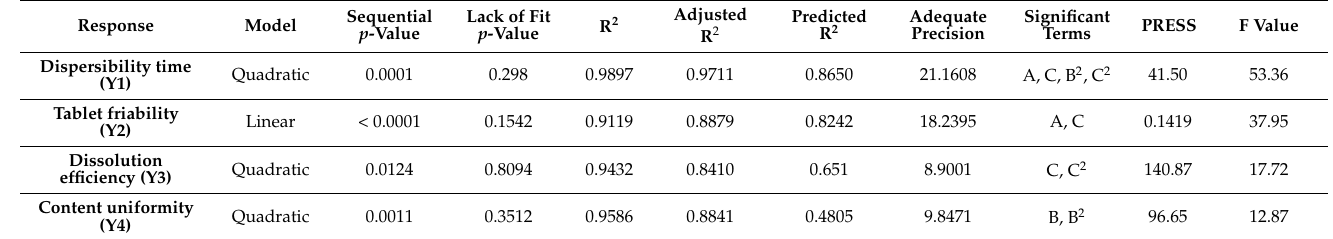
Table 4. ANOVA analysis for the selected models for different responses of